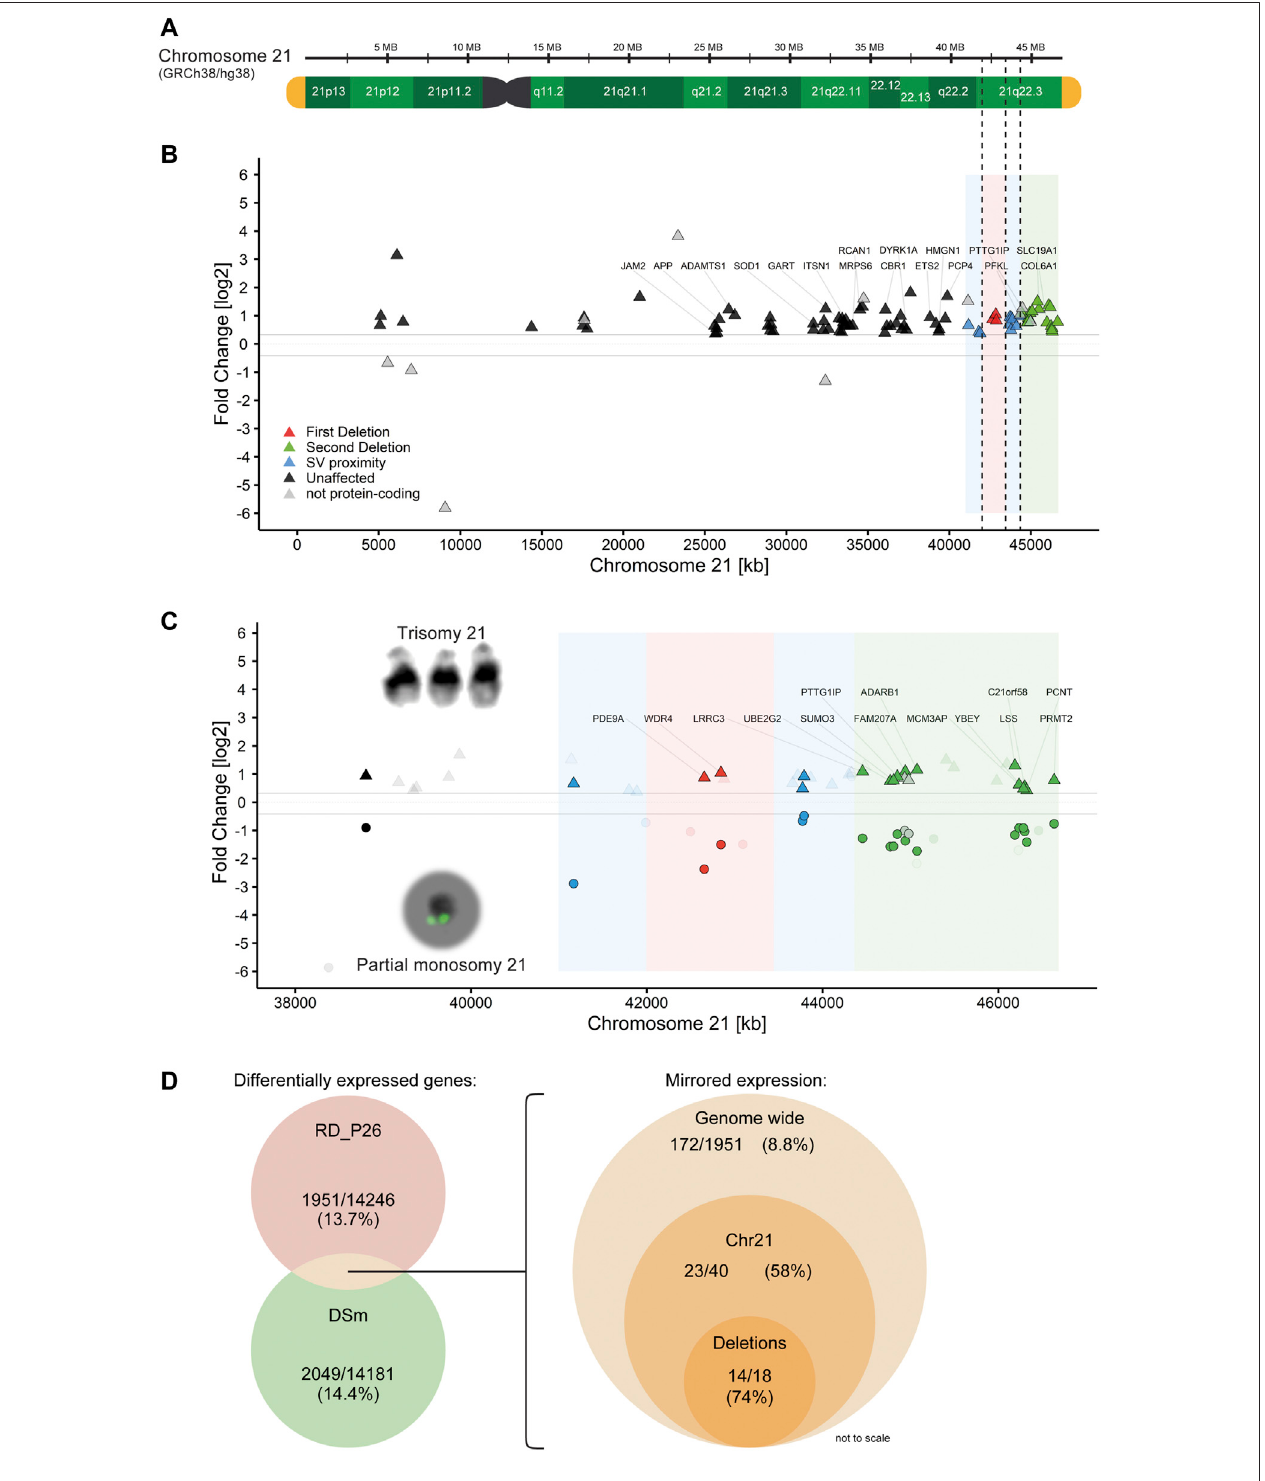
FIGURE 4 | Partial monosomy 21 acts as transcriptomic mirror to trisomy 21 (A) Reference genome GRCh38/hg38 shown with G-bands (green), telomeres (yellow)anddeletionsfromRD_P26(dashedline) (B) Geneexpressionofthetrisomy21sampleDSmonchromosome21.Showngenesaresigni fi cantlyanddifferentially ( ± 25%) expressed. Genes related to Down Syndrome ( Supplementary Table S7 ) are labelled. Deletions (red, green) and 1 Mb vicinity (blue) of RD_P26 are shown as color sections (C) Gene expression of signi fi cantly and differentially expressed genes grouped for DSm (triangles) and RD_P26 (circles). Genes were marked for protein-coding + mirrored (satiated color), non-coding genes (gray) and not-shared among the two samples (transparent). Only genes within the two deletions are